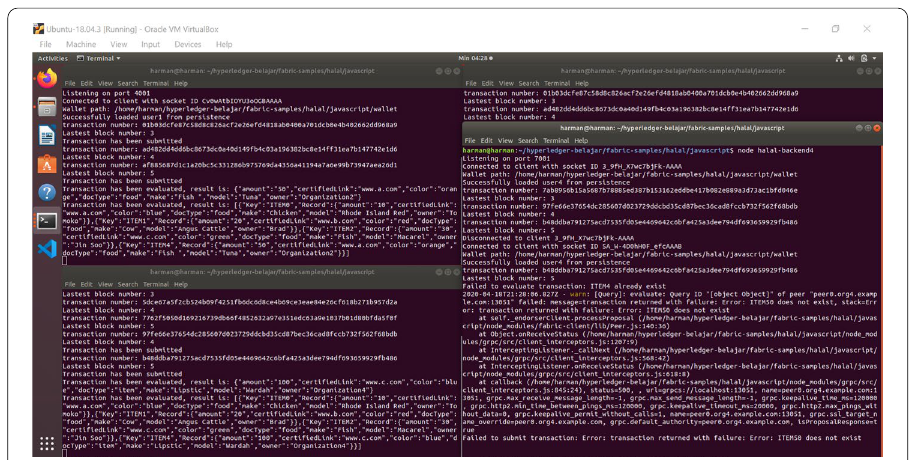
Fig. 5 Back end of Blockchain Network’s web